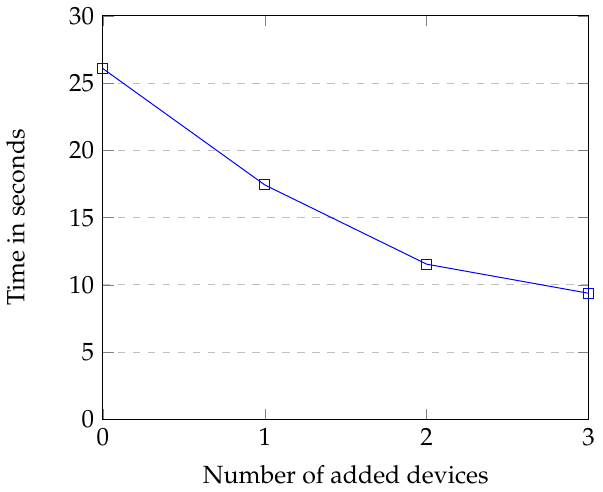
Figure 3. Result of adding devices to n 1